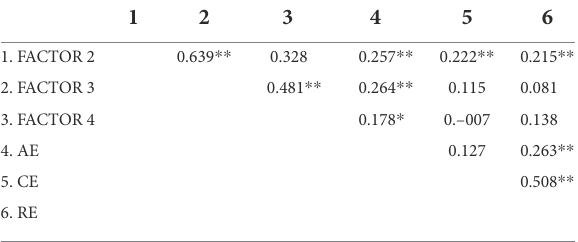
TABLE 2 Preliminary